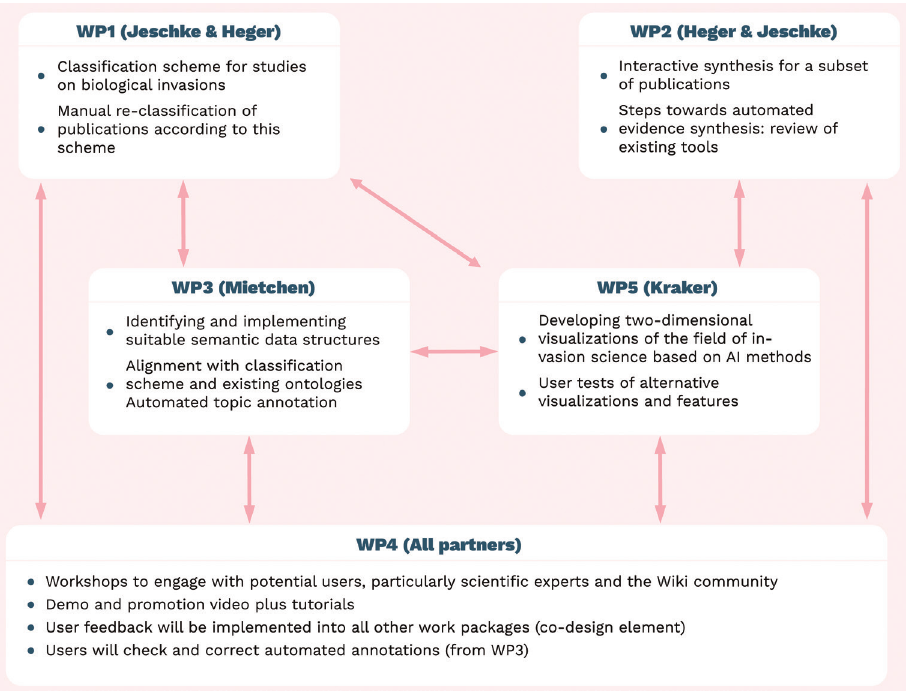
Figure 2. Scheme of the five work packages (WPs) and how they interrelate. Please see main text for